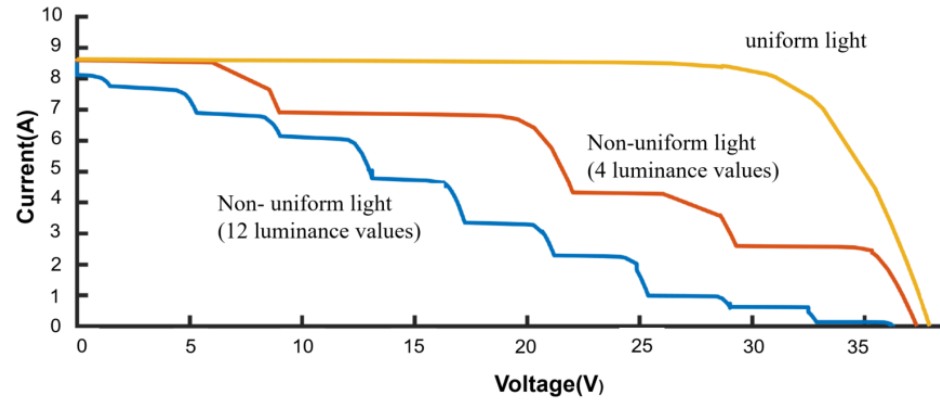
Figure 6. V–I curve under laser Figure 6. V – I curve under laser irradiation.